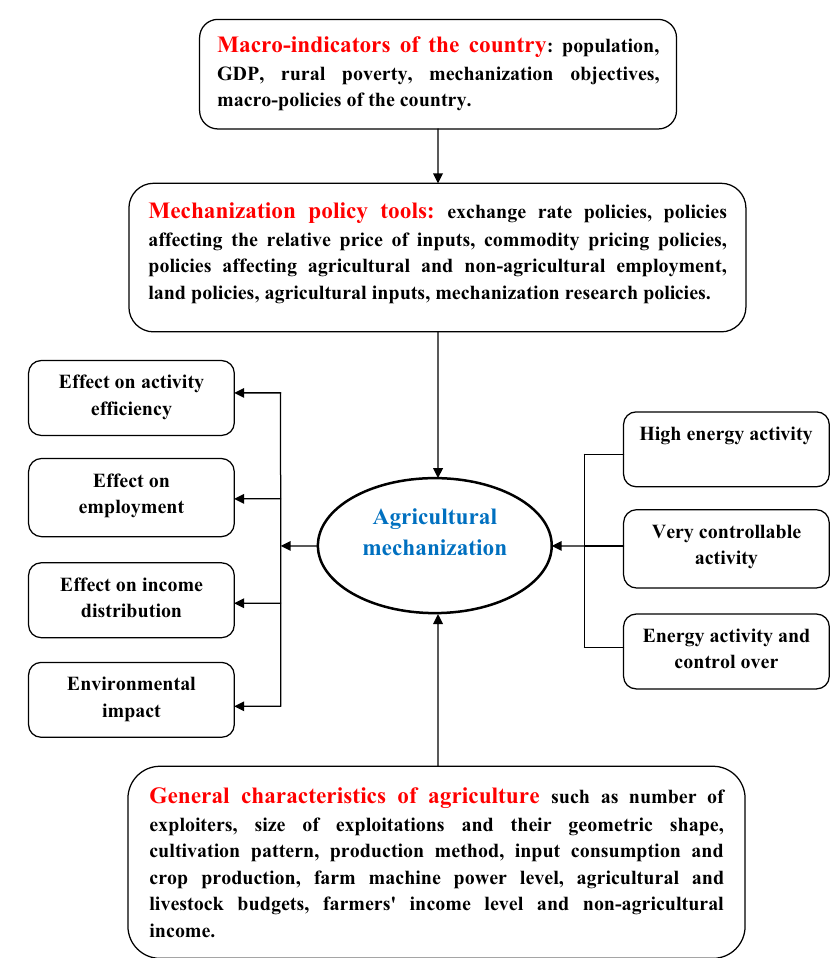
Figure 1: Factors a ff ecting agricultural mechanization and its e ff ects in the agricultural